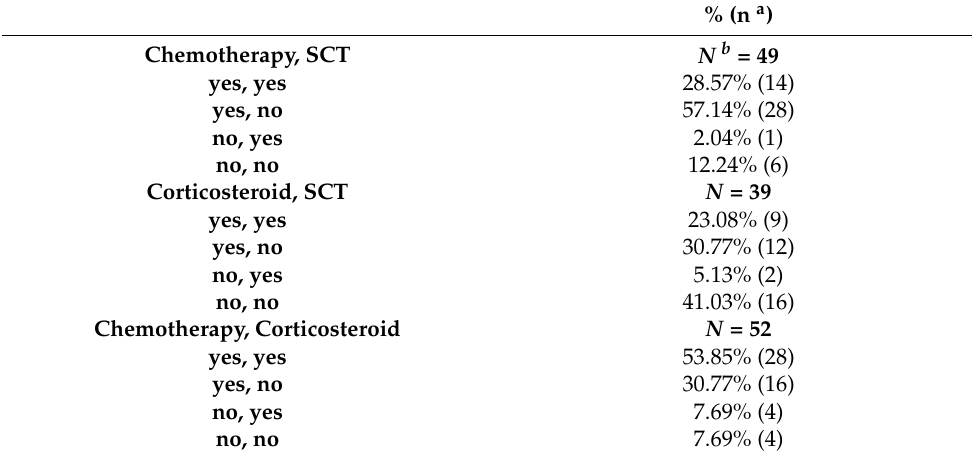
Table 5. Multiple risk factors for dissemination.